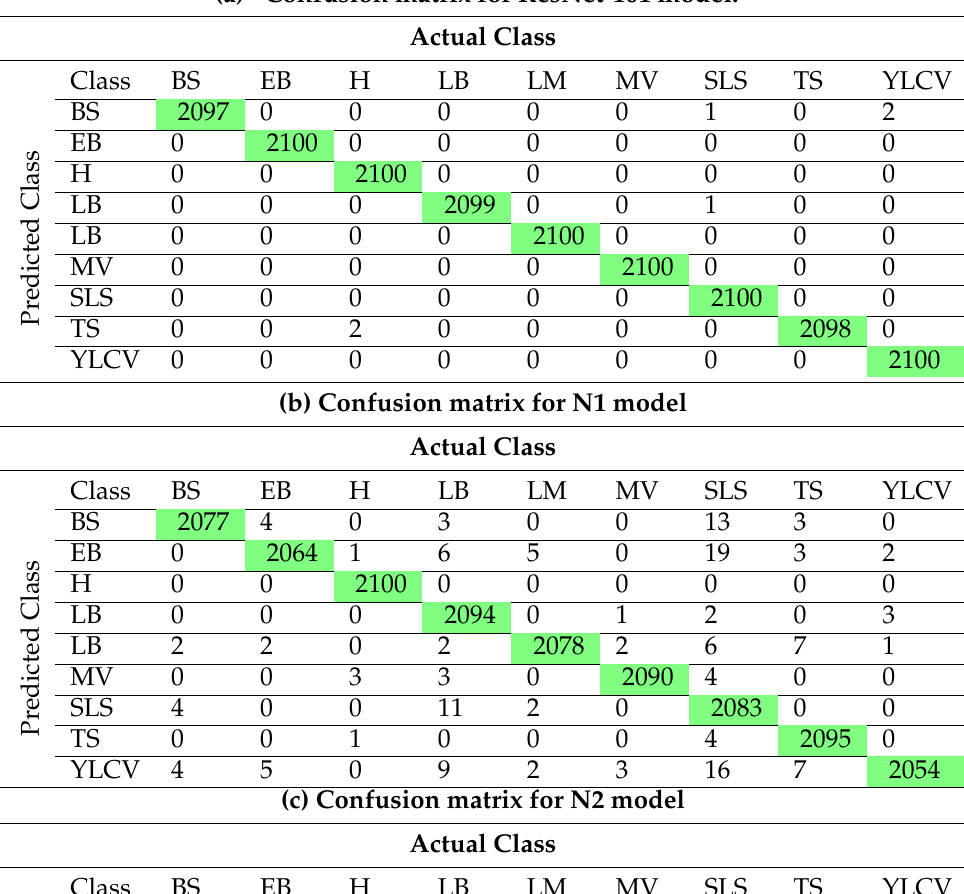
Table 5. Confusion matrix for proposed models for the PV dataset. (a) “Confusion matrix for ResNet-101 model.”